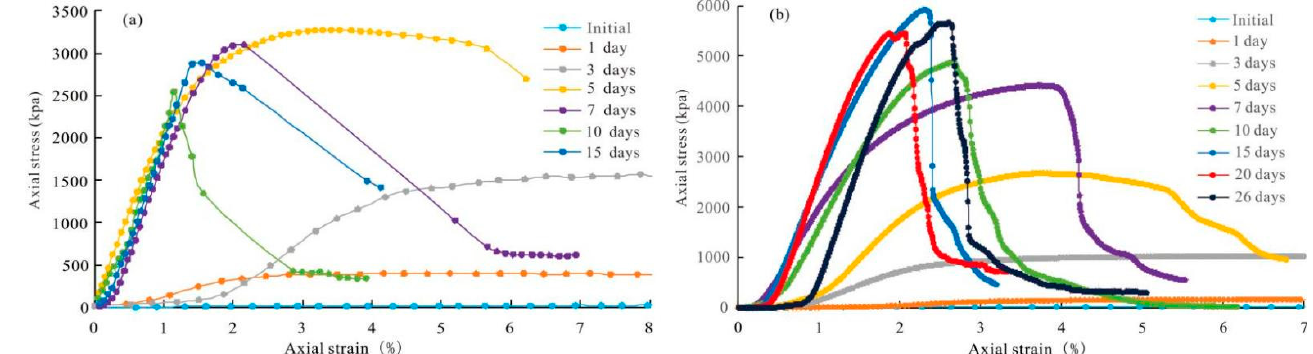
Figure 9. Stress-strain curves of expansive soil varying with dehydration time under different environment conditions ( a ) 50 °C-10%, ( b ) 50 °C-70%.